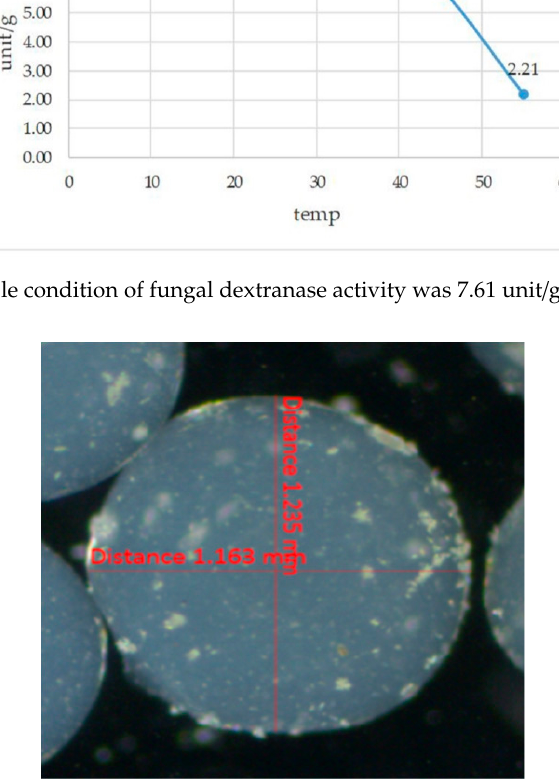
Figure A3. The effect of crude dextranase from P . roquefortii TISTR 3511 on biofilm adherent capability of S . mutans ATCC 25175, comparison between negative control, positive control and crude dextranase . References 1. Wang, D.; Lu, M.; Wang, A.S.; Jiao, Y.; Li, W.; Zhu, Q.; Liu, Z. Purification and characterization of a novel marine Arthrobacter